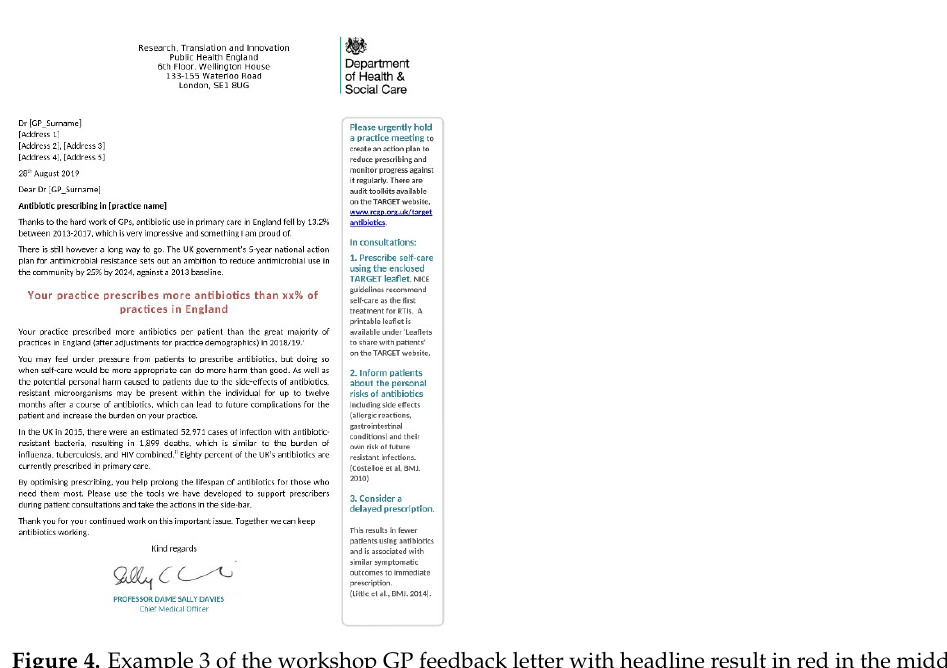
Figure 4. Example 3 of the workshop GP feedback letter with headline result in red in the middle of the letter and three key action points boxed to the right of the main text.